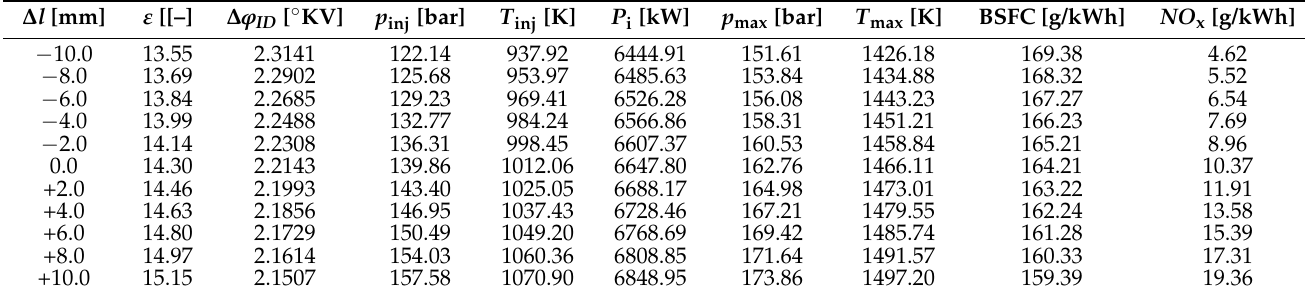
Table 12. Engine parameters and NO x emission changes due to changes in the compression ratio at 75% MCR [22].